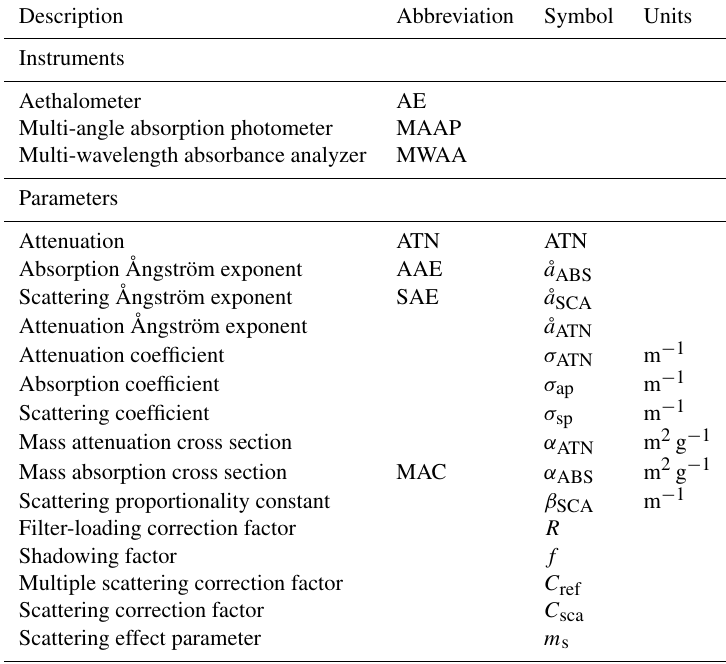
Table 1. List of symbols and abbreviations